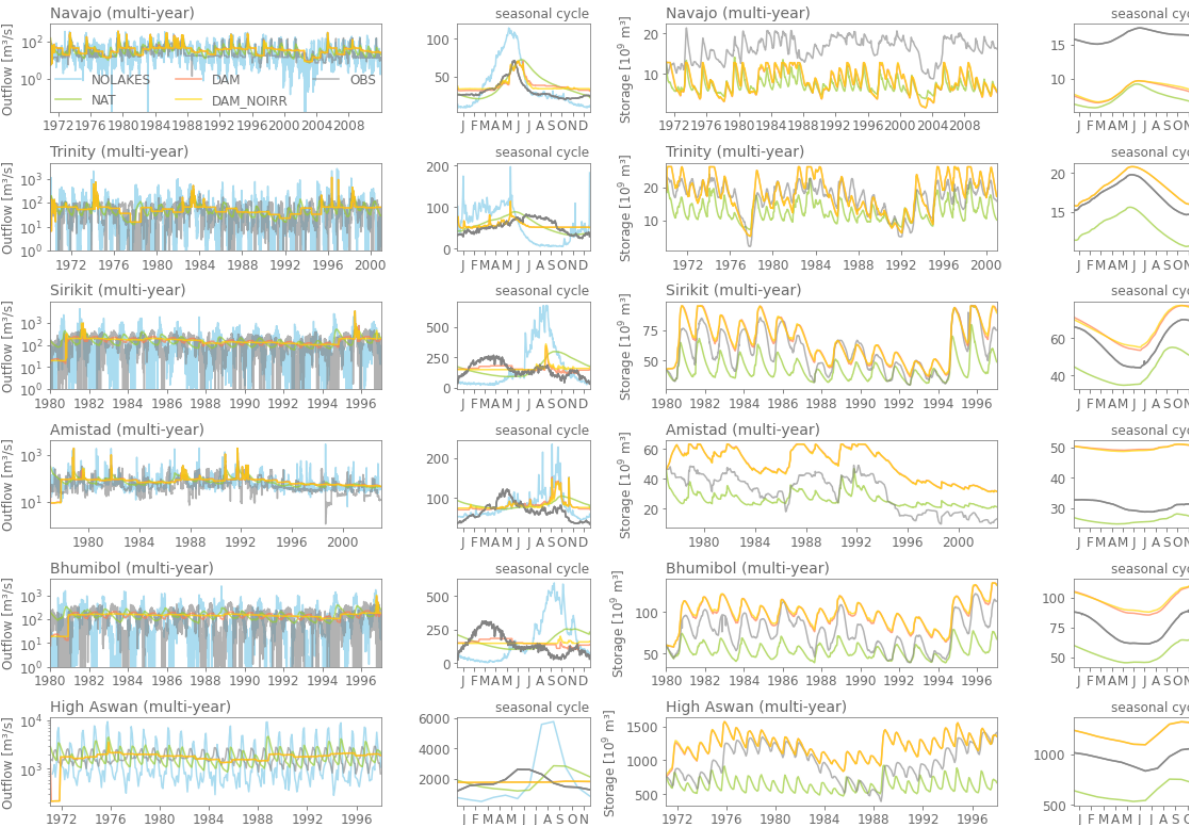
Figure A2. Time series and seasonal cycles of outflows and storage of observation driven simulations using the Hanasaki et al. (2006) parametrization with and without accounting for irrigation (DAM and NO_DAM, respectively), the natural lakes Döll et al. (2003) parametrization (NAT), and run-of-the-river conditions (NOLAKES, all for irrigation reservoirs), compared to observations. Note the loga- rithmic axis for the outflow time